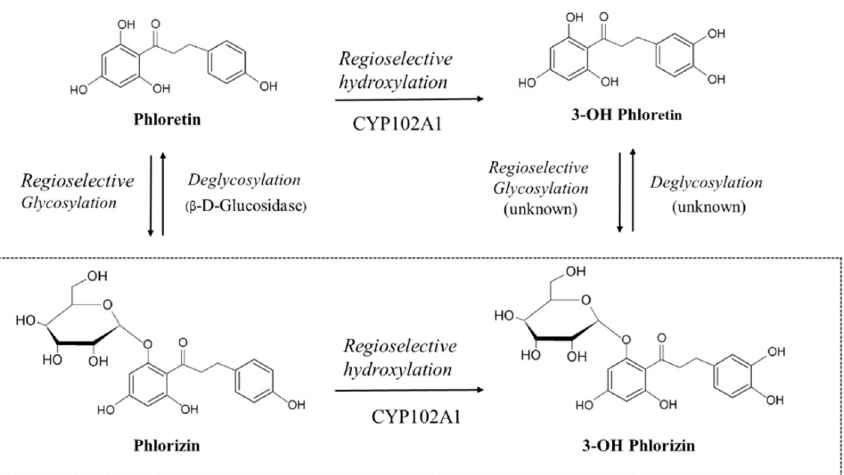
Figure 1. CYP102A1 catalyzed regioselective hydroxylation of phlorizin to produce 3-OH phlorizin. A scheme of currently found enzymatic interconversion reactions of phloretin, 3-OH phloretin, and phlorizin is also shown. In the present study, enzymatic conversion from phlorizin to 3-OH phlorizin was studied using CYP102A1 in the presence of NADPH.